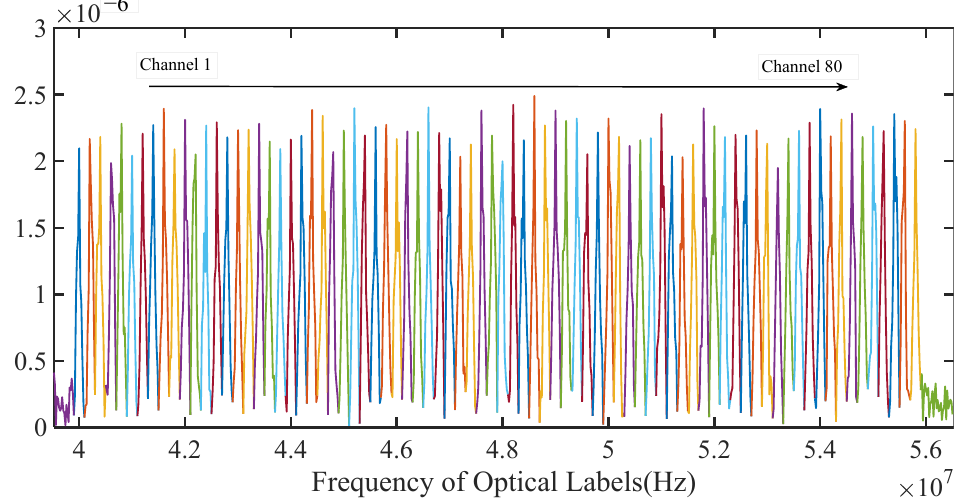
Figure 2. Spectrum of the detected optical label of 80-channel WDM systems.